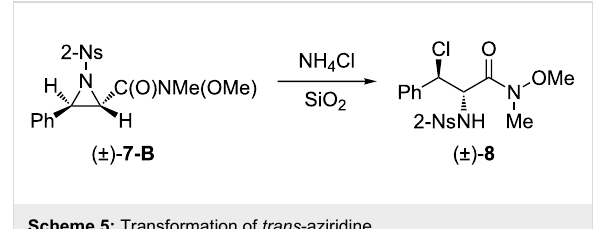
Scheme 5: Transformation of trans